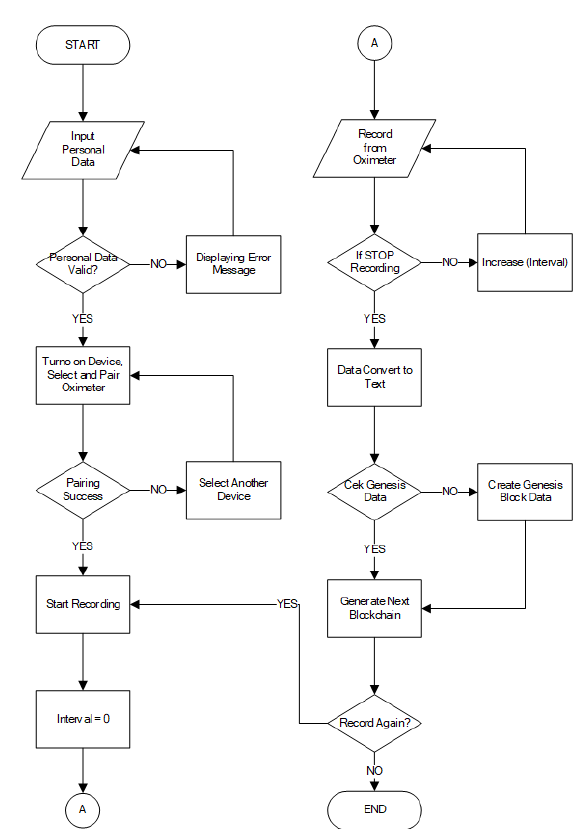
Fig. 5. Flowchart of The Proposed System.